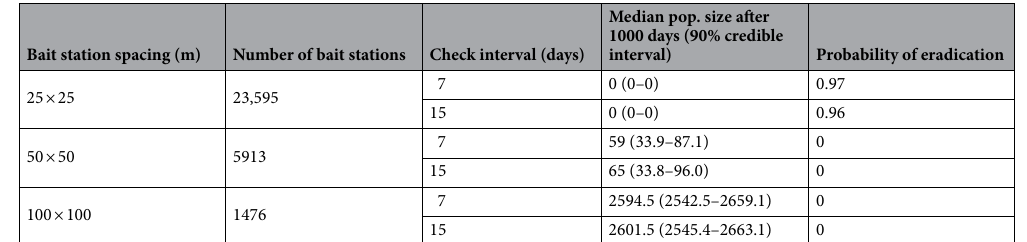
Table 2. Results from ship rat ( Rattus rattus ) baiting simulations using the trapping model of Gormley and Warburton (2020) 75 . Simulations were run for three different bait station spacings and two checking intervals (7 or 15 days) over a 1475 ha that will be targeted for ship rat eradication in Wellington city, New Zealand; bait stations were active for 1000 days. Each bait station layout and checking interval simulation was run 100 times, with each repetition starting with a different layout of bait stations and ship rat locations. We calculated the probability of rat eradication after 1000 days of baiting as the proportion of iterations where rat density was reduced to zero.